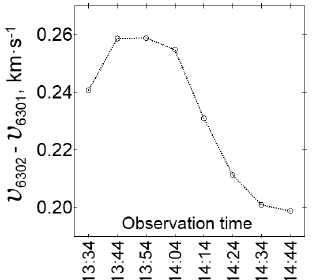
The differences between bisector points at the equal “relative” heights for 6302 and 6301 lines. Solid line – mean values, others – values for individual